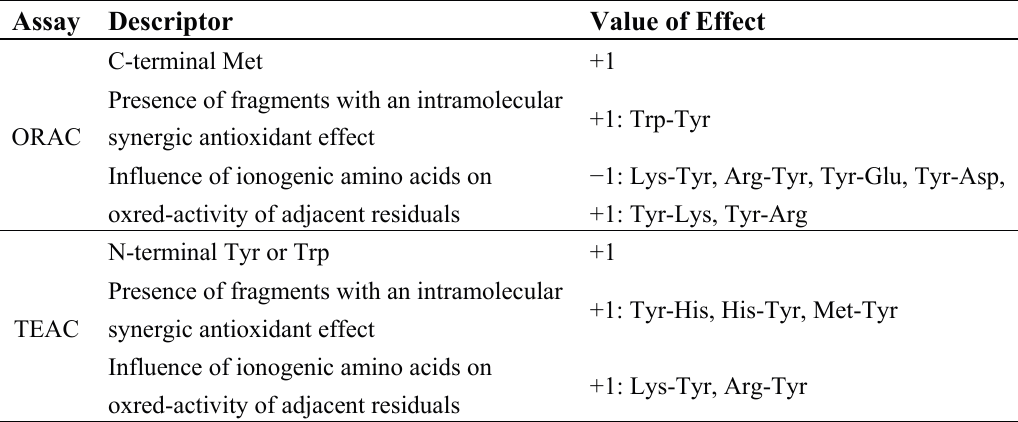
Table 10. Molecular descriptors of antioxidant activity for peptides.